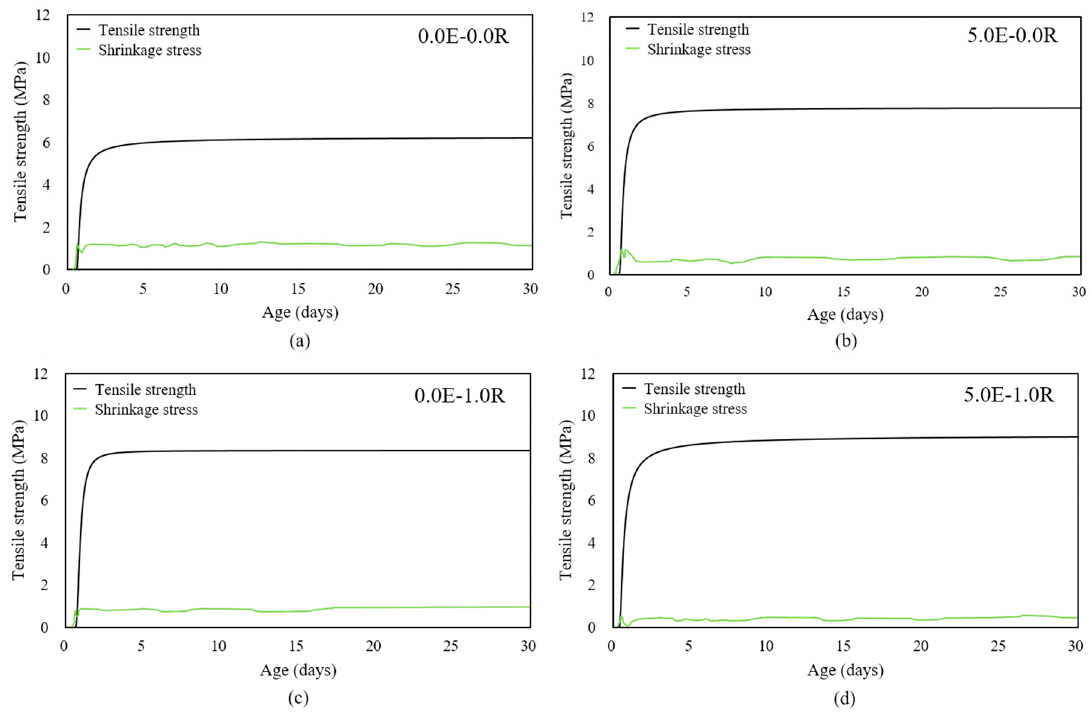
Figure 8. Comparison of tensile strengths and autogenous shrinkage stress; ( a ) 0.0E-0.0R, ( b ) 5.0E-0.0R, ( c ) 0.0E-1.0R, and ( d ) 5.0E-1.0R.